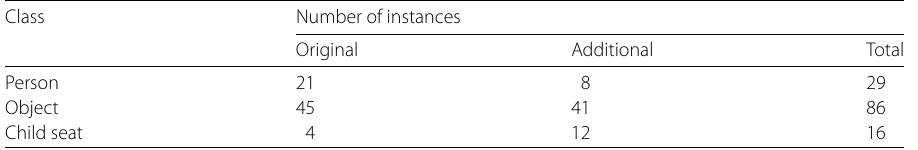
Table 12 Number of instances per class in the training set Class Number of